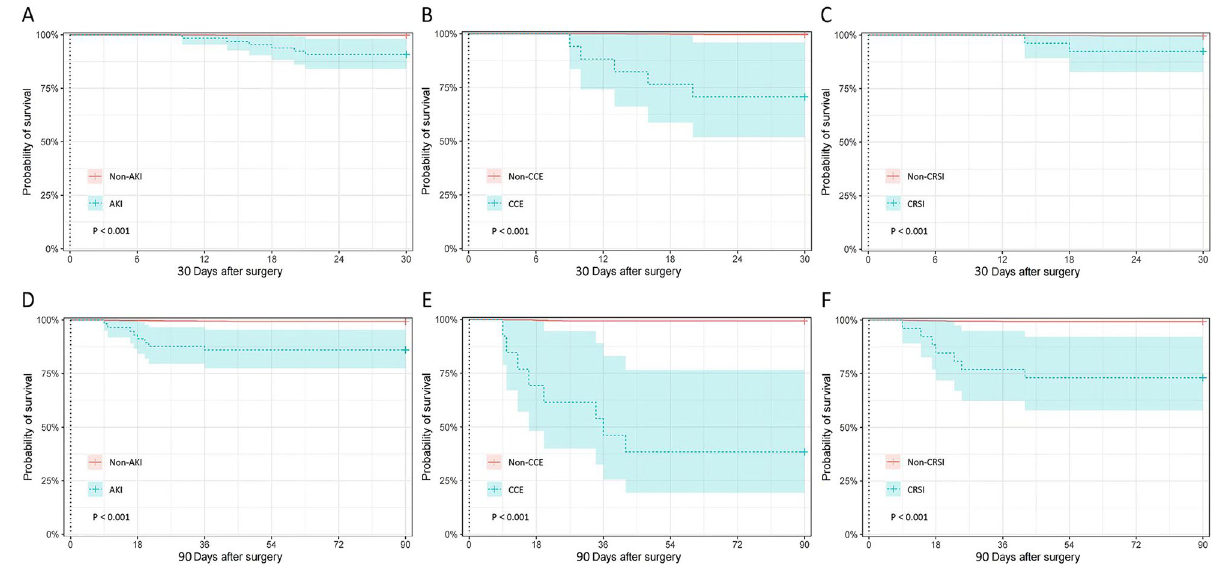
Figure 2. Cox survival curves of CCE, AKI and CSRI. CCE: cardiovascular and cerebrovascular event; AKI: Acute Kidney Injury; CRSI: complications requiring surgical intervention.